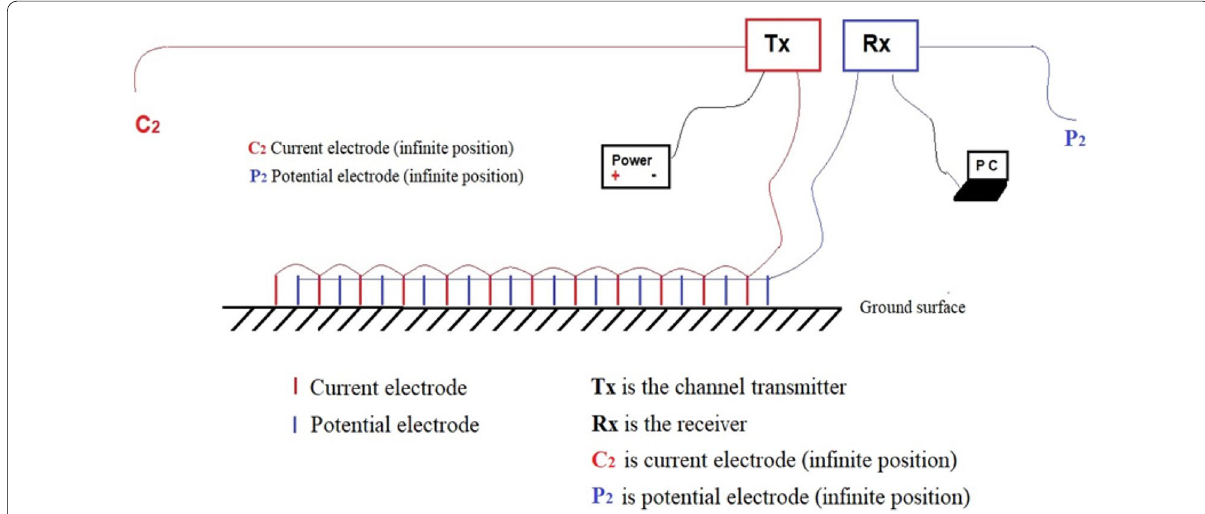
Fig. 4 A sketch showing the working concept of